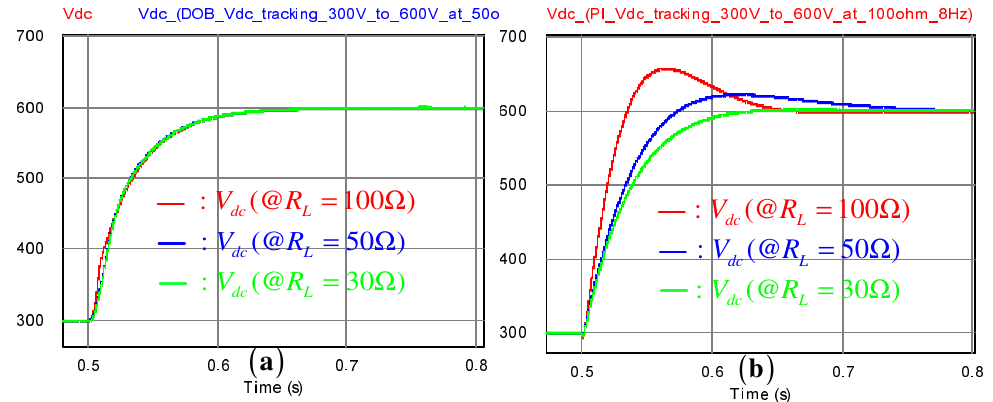
Figure 7. The DC-link voltage tracking performance variation comparison between the proposed method ( a ) and the feedback linearizing (FL) method ( b ) at three resistive loads: R L = 100,50,30 Ω